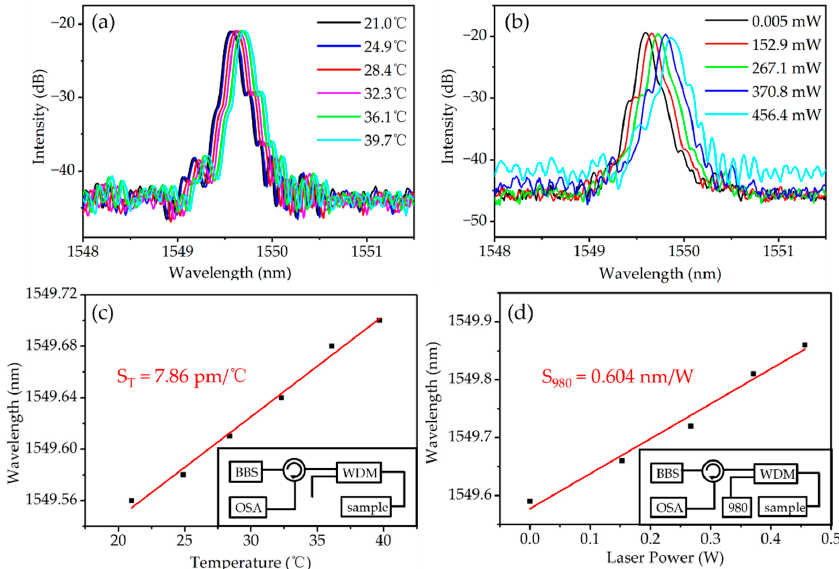
Figure 2. ( a ) Measured spectra of the sensor corresponding to the ambient temperature in the range 21.0–39.9 °C. ( b ) Measured spectra of the sensor corresponding to the heating laser power in the range 0.005–456.4 mW. ( c ) Ambient temperature response of the HAFBG Bragg wavelength. Inset: Schematic diagram of the experimental setup for temperature measurement. ( d ) Heating laser power response of the HAFBG Bragg wavelength. Inset: Schematic diagram of the experimental setup for heating laser power measurement.